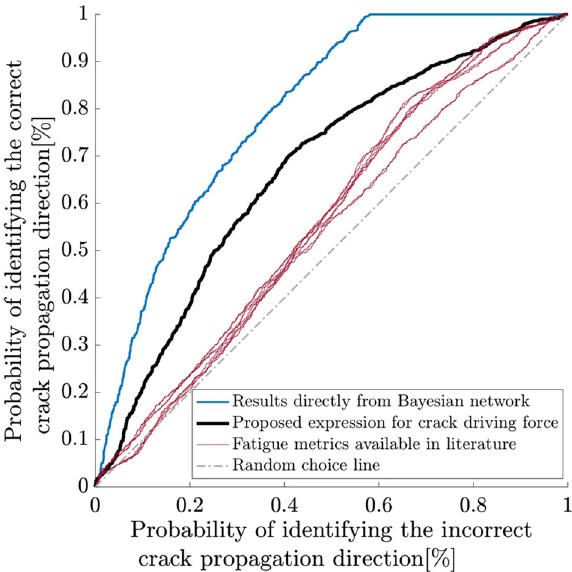
Fig. 8 Performance comparison for different models. The task is to predict crack growth directions. Performances of a Bayesian network model, a machine learning designed analytical equation surrogate model, and some traditional analytical fatigue metrics are given in receiver operative characteristic (ROC) curves. Curves further away from the diagonal indicate better performances. Figure reprinted from ref. 78 under the CC BY 4.0 license 156 .